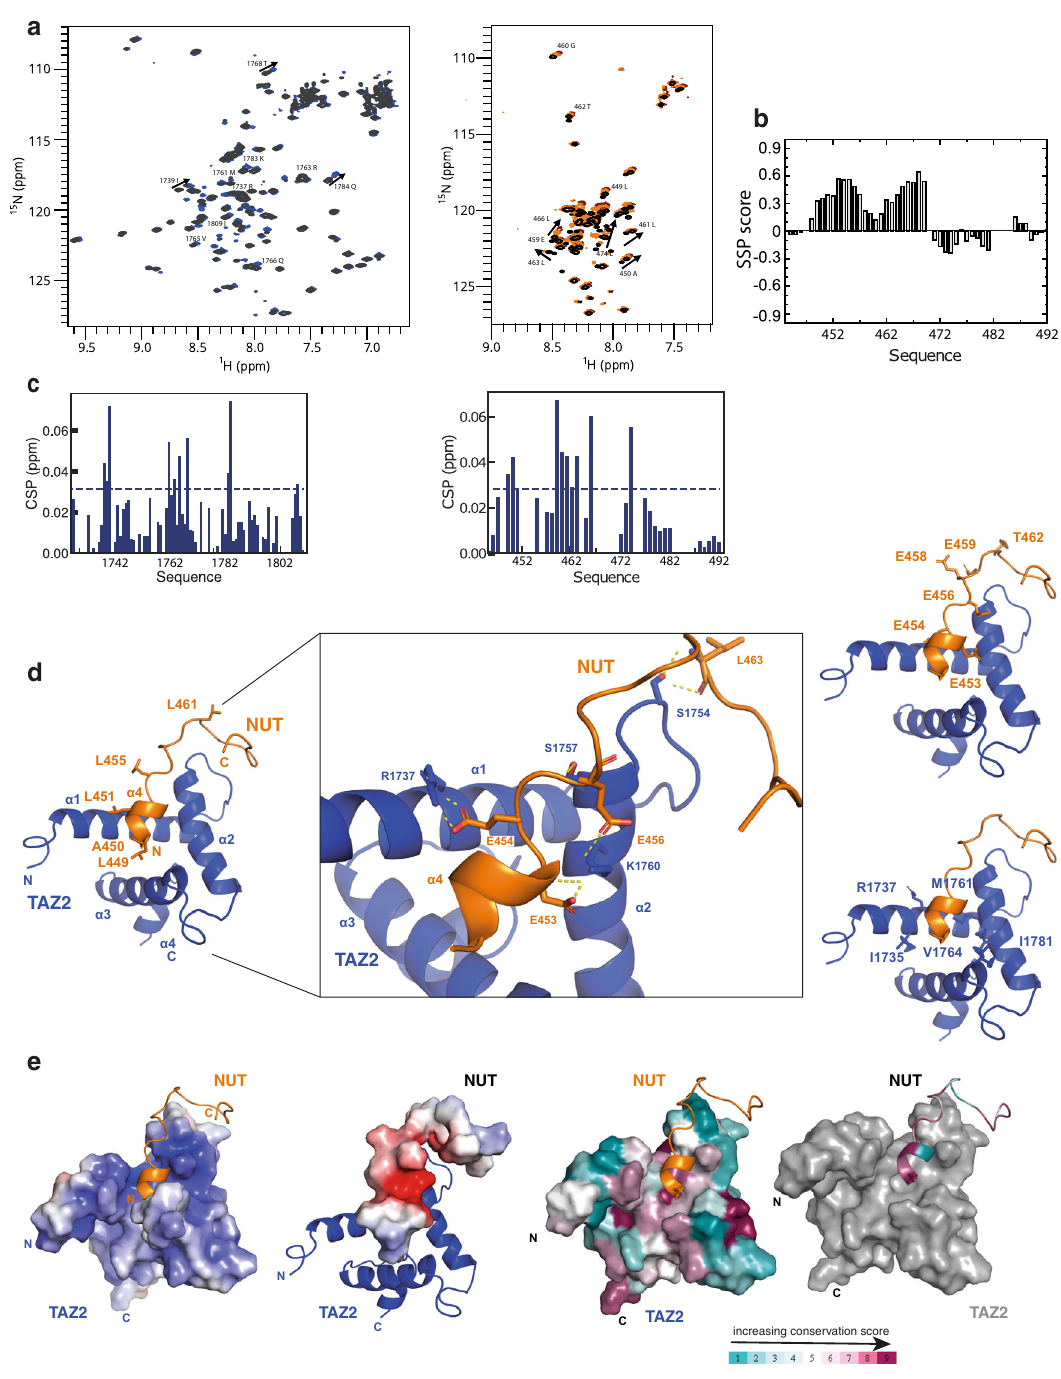
Fig. 2 | TAZ2:NUTinteraction. a (Left) Overlay of 1 H- 15 N HSQC spectra of free TAZ2 (black) and after addition of one molar equivalent of NUT7 (448-492) (blue). Arrows indicate chemical shift changes for individual cross-peaks. (Right) Overlay of 1 H- 15 N HSQCspectraoffreeNUT7(448-492)andafteraddinghalf(orange)andone(brown) molarequivalentofTAZ2.Arrowsindicatechemicalshiftchangesforindividualcross- peaks. b Secondary structure propensities (SSP) plot of the NUT (448-492) fragment initsfreestate.positivevaluesontheY-axisindicatea-helicalpropensity,theX-axisis the amino acid sequence. c (Left) Chemicalshiftperturbations on TAZ2uponadding one molar equivalent of unlabelled NUT7 (448-492). (Right) Chemical shift